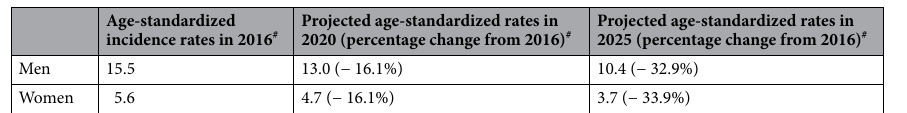
Table 1. Age-standardized incidence rates of bladder cancer per 100,000 people (observed in 2016 and projected in 2020 and 2025) and the percentage changes from 2016 to 2020 and from 2016 to 2025. # WHO’s 2000 World Standard Populations were used to compute the truncated age-standardized incidence rate (age range 25–85 +).